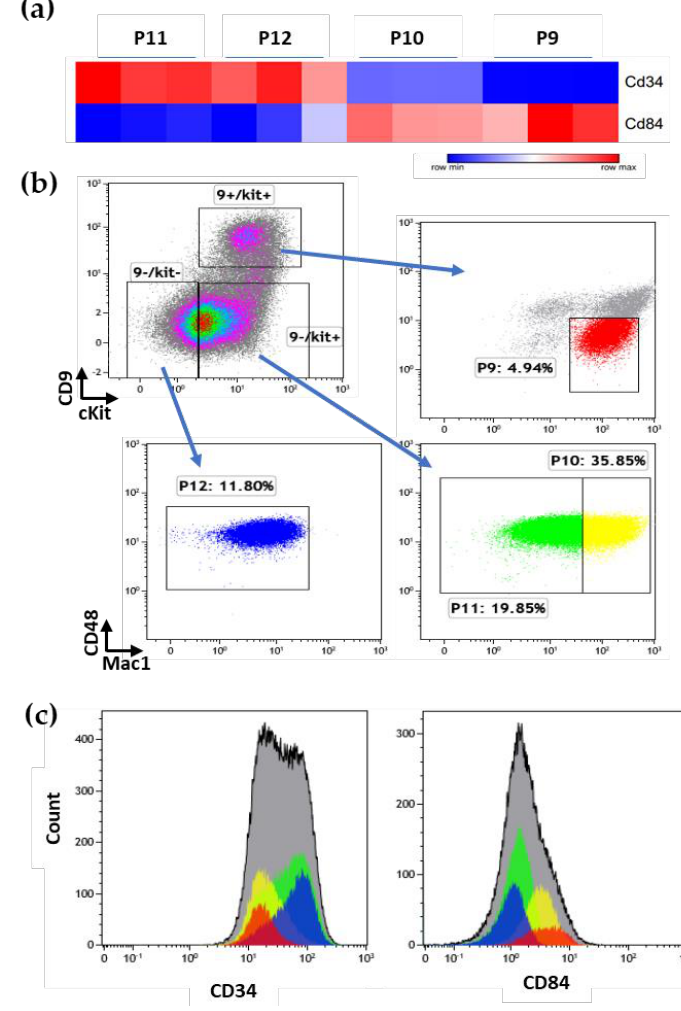
Figure 6. CD34 and CD84 are differentially expressed on ML23 sub-populations, in agreement with RNAseq data: ( a ) Heatmap of mRNA levels of Cd34 and Cd84 in the ML23 sub-populations. ( b , c ) Fresh ML23 cells were stained for the primary four surface markers in addition to CD34 and CD84 proteins. The expression level of each of the markers was examined in each of the sub-populations. Representative data are shown from one out of three independent experiments.